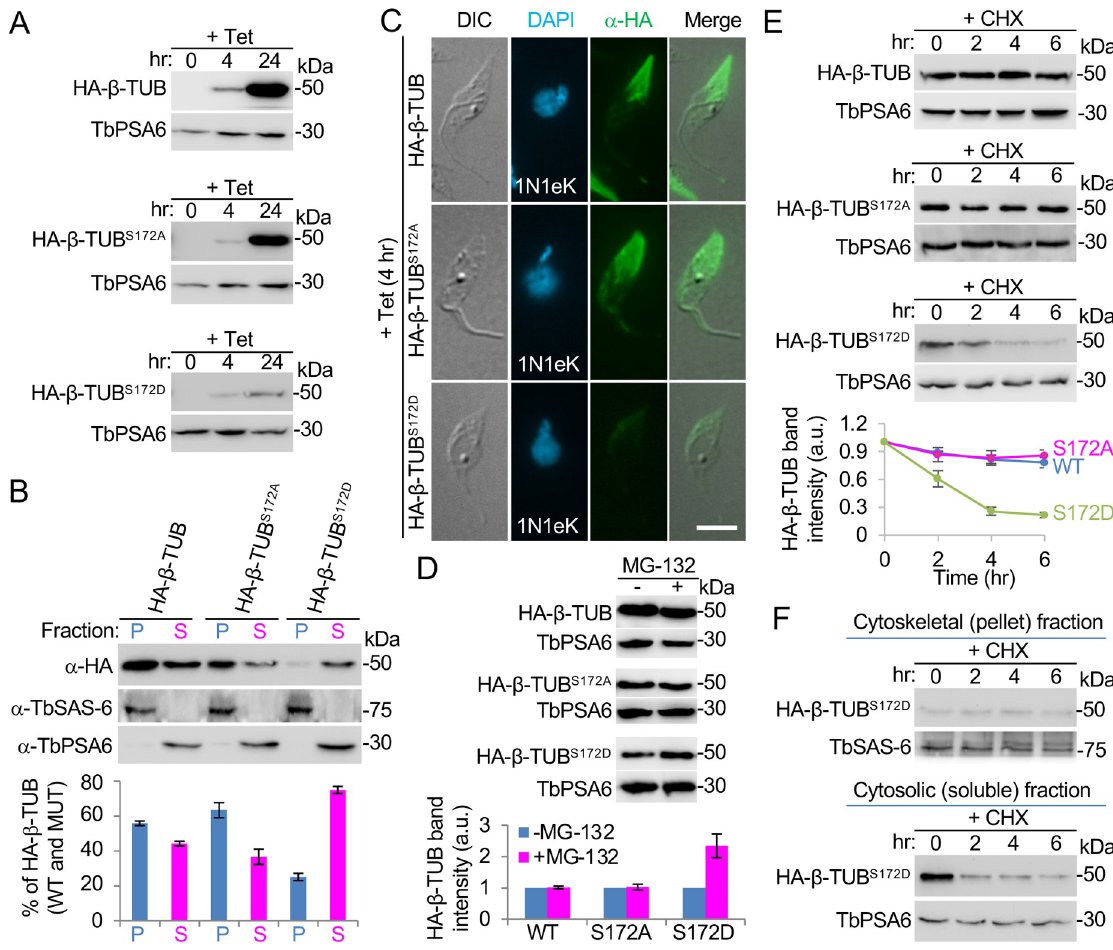
Fig 6. Phosphorylation of β -tubulin on Ser-172 by CRK2 impairs its incorporation into cytoskeletal microtubules. ( A ). Western blotting to monitor the ectopically expressed control tagged β -tubulin, the S172A mutant, and the S172D mutant tagged with an N-terminal HA epitope. TbPSA6 served as a loading control. ( B ). Distribution of control tagged β -tubulin, the S172A mutant, and the S172D mutant in the cytosolic and cytoskeletal fractions of T . brucei cells. TbSAS-6 served as the cytoskeleton marker, and TbPSA6 served as the cytosol marker. The histogram shows the relative amounts of β -tubulin and its mutants, and error bars indicate S.D. from three independent biological replicates. ( C ). Incorporation of β -tubulin and its S172 mutants into the corset microtubules examined by immunofluorescence microscopy with FITC-conjugated anti-HA antibody. Scale bar: 5 μ m. ( D ). Effect of MG-132 treatment on the stability of control tagged β - tubulin, the S172A mutant, and the S172D mutant. The histogram shows the band intensity of control tagged β -tubulin and β -tubulin mutants, which was normalized against the loading control TbPSA6. Error bars indicate S.D. (n = 3). ( E ). Stability of β -tubulin and its mutants examined by cycloheximide pulse-chase experiment. The histograms show the band intensity of β -tubulin and its mutants, which was normalized against the loading control TbPSA6 and then expressed relative to the first time point (0 hr). Error bars indicate S.D. from three independent biological replicates. ( F ). Stability of the S172D mutant in the cytosol and the cytoskeleton examined by cycloheximide pulse-chase